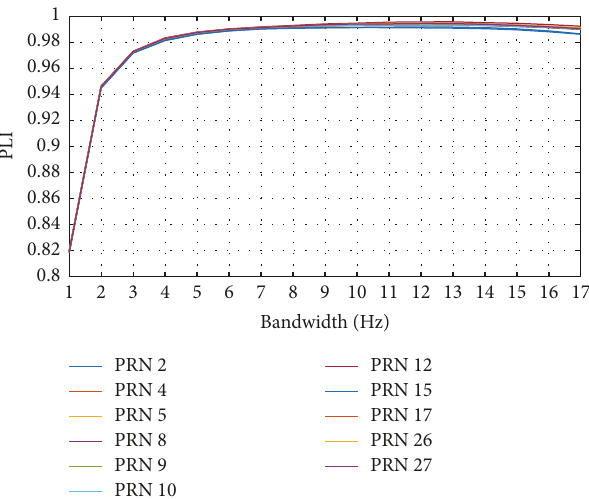
Figure 5: Mean of PLI under different bandwidth for the data set with 47 dB-Hz data